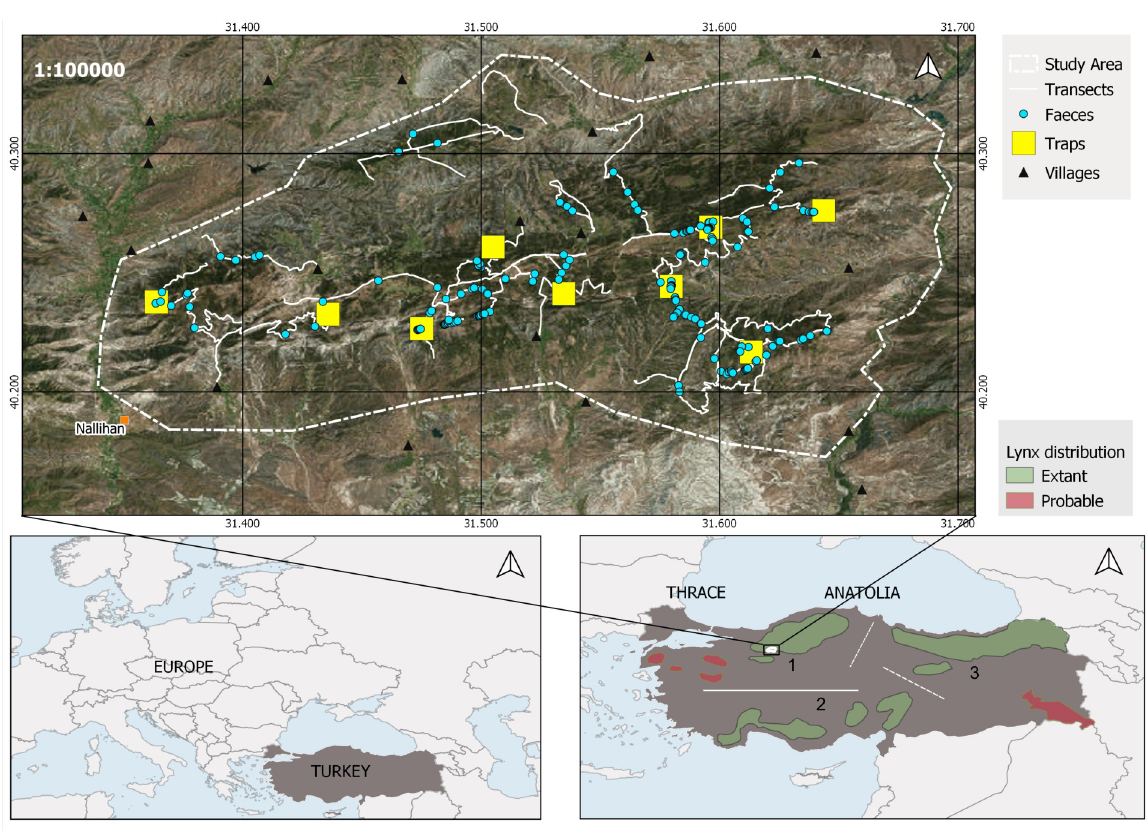
Fig 1. Location of the study area in north-west Anatolia and distribution of the three big extant lynx populations. 1: Northwestern, 2: southern, 3: northeastern lynx populations [11]. The continuous line indicates complete and dashed lines indicate potential isolation.